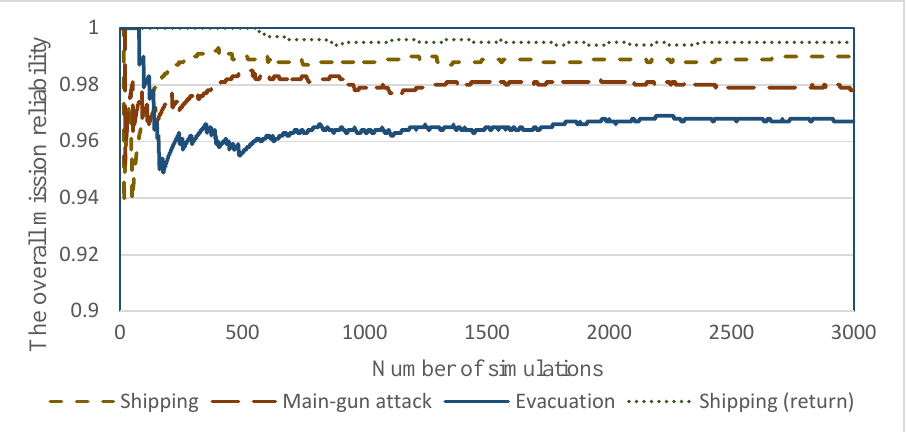
Figure 15. The mission reliability of each unit task.